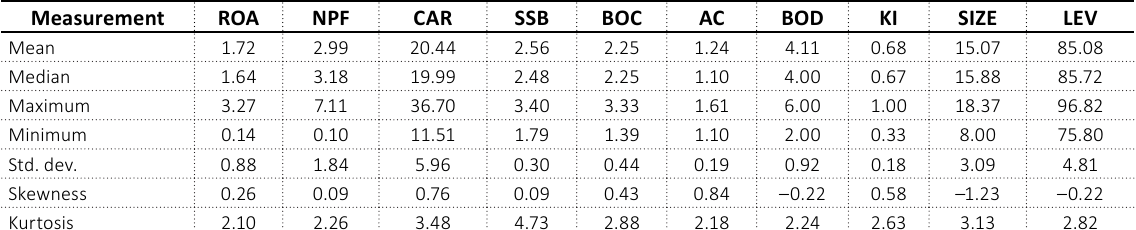
Table 2. Descriptive statistics